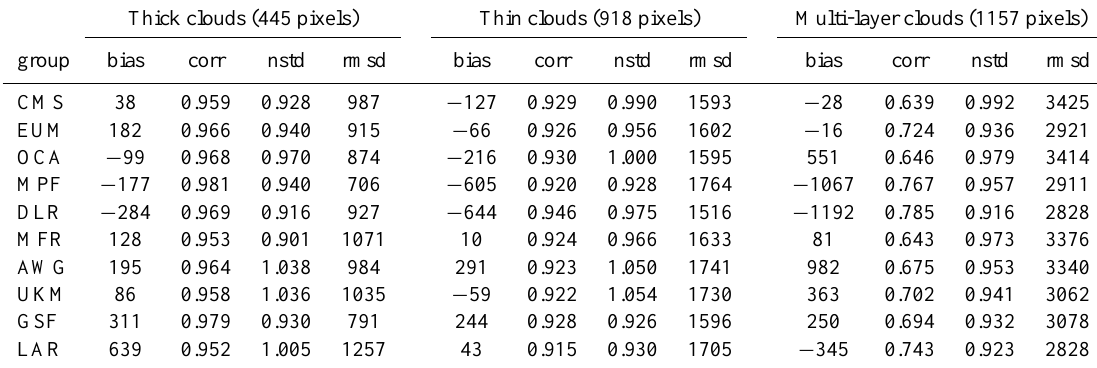
Table 10. Same as Table 9, but for CPR. For clarification the same criteria using CALIOP products are applied for separation of the cloud regimes. The mean CTHs observed by CPR are 4289, 5208 and 7919m and the standard deviations are 3480, 4236 and 4050m for thick, thin and multi-layer clouds,